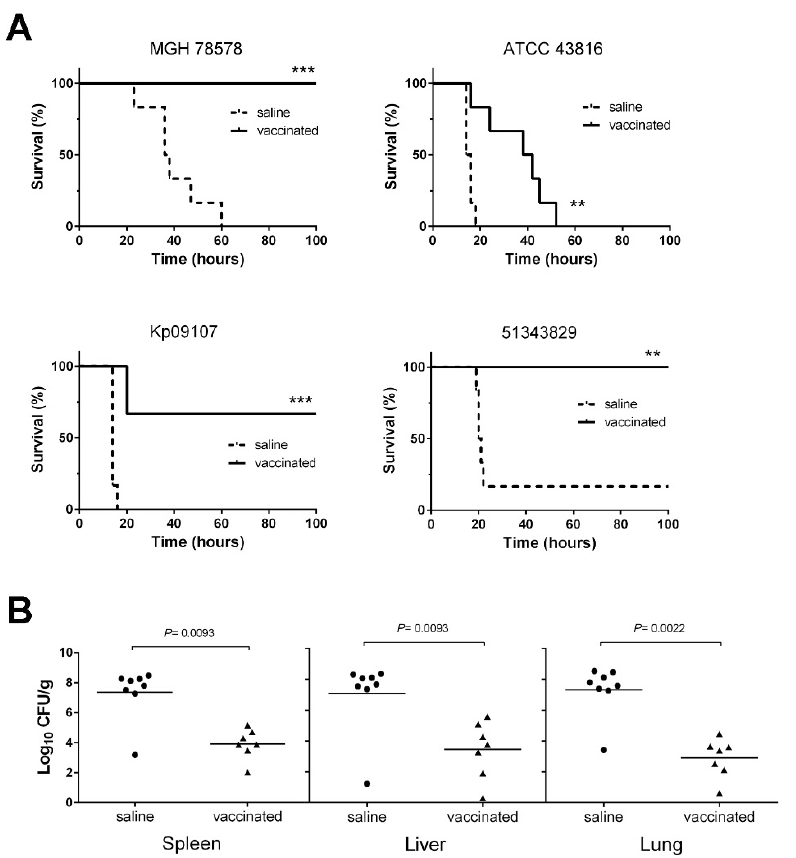
Figure 6. Vaccinated mice were protected from infection by K. pneumoniae . ( A ) Survival of BALB/c mice ( n = 6) following i.p. infection with a lethal dose of different strains of K. pneumoniae : MGH 78578 (2.3 × 10 7 CFU), Kp09107 (7.2 × 10 6 CFU), ATCC 43816 (8.6 × 10 4 CFU) and 51343829 (5.2 × 10 7 CFU). Vaccinated mice were inoculated on days 0 and 14 with the MGH 78578 ∆ murI strain (6.2 × 10 6 CFU), while uninoculated mice were administered saline on the same days. Both mouse groups were infected with the wild-type strain on day 21. ** p < 0.005, *** p = 0.0005 survival of vaccinated group compared to the control group; p -values according to the Mantel–Cox log-rank test. ( B ) Bacterial loads in the spleens, livers and lungs obtained from immunized and control mice ( n = 7–8) 36 h after infection with MGH 78578 (3.2 × 10 8 CFU). Each symbol represents an individual mouse, and the horizontal lines show the averages for each group. p -values for the Mantel–Cox log-rank test.